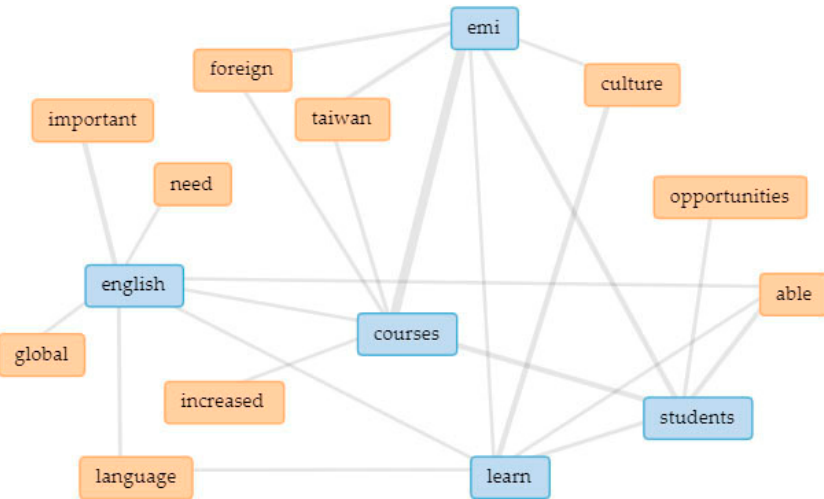
Figure 3. Interrelationships and extended links among the five main keywords.